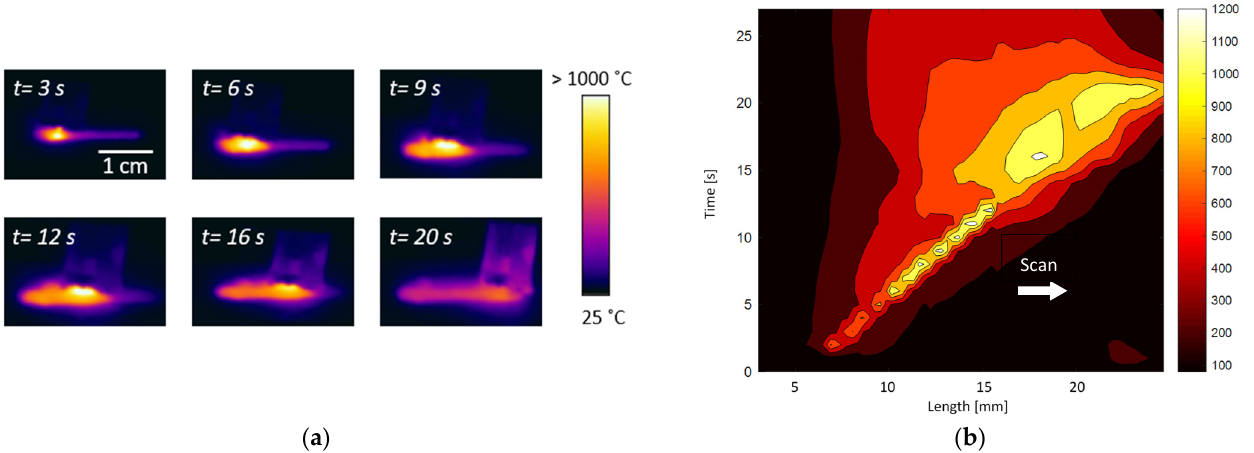
Figure 3. Temperature measurements of a scanning LMH–AM process along the 1D powder bed: ( a ) Thermal camera images in different times, showing the hotspot progress along the x axis. ( b ) The spatiotemporal evolution of the temperature along the scanned powder axis, measured by the thermal camera during the LMH–AM scanning process along the x axis vs. time. The scanning direction is indicated by the white arrow. The motion of the hotspot is evidenced by the yellow front line (>900 °C), propagating along the x and t dimensions at a ~1 mm/s speed.